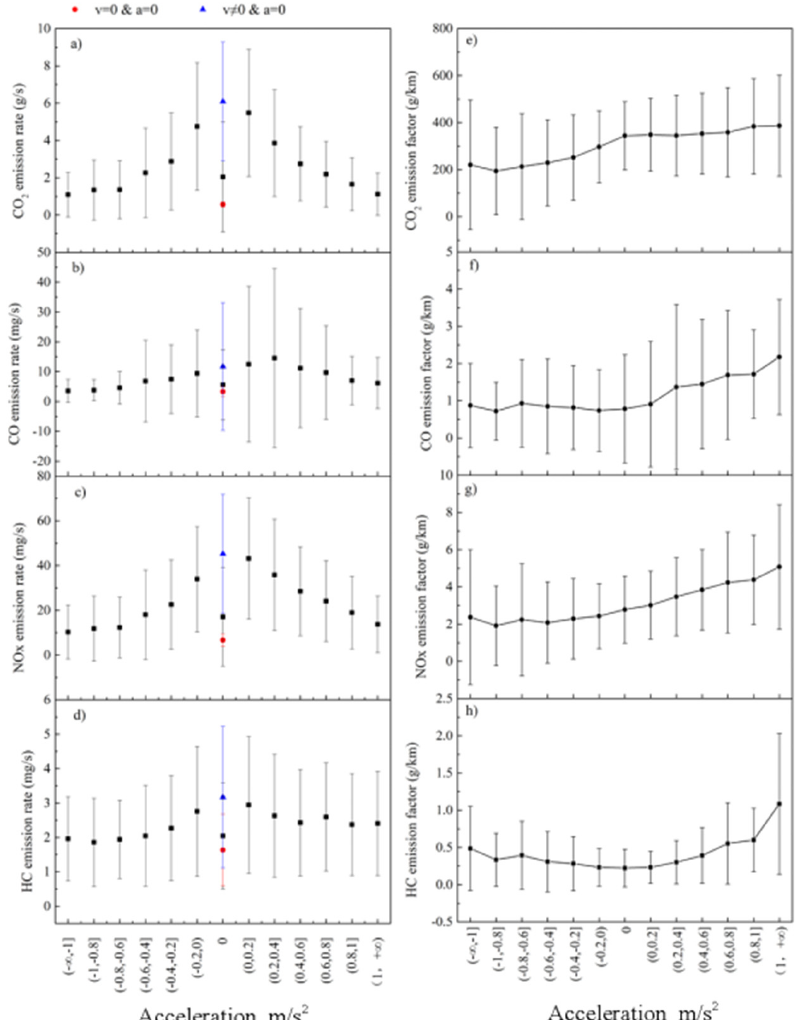
Figure 5. The average emission rates ( a – d ) and EFs ( e – h ) of CO, HC and NOx from LDDTs in different acceleration intervals.